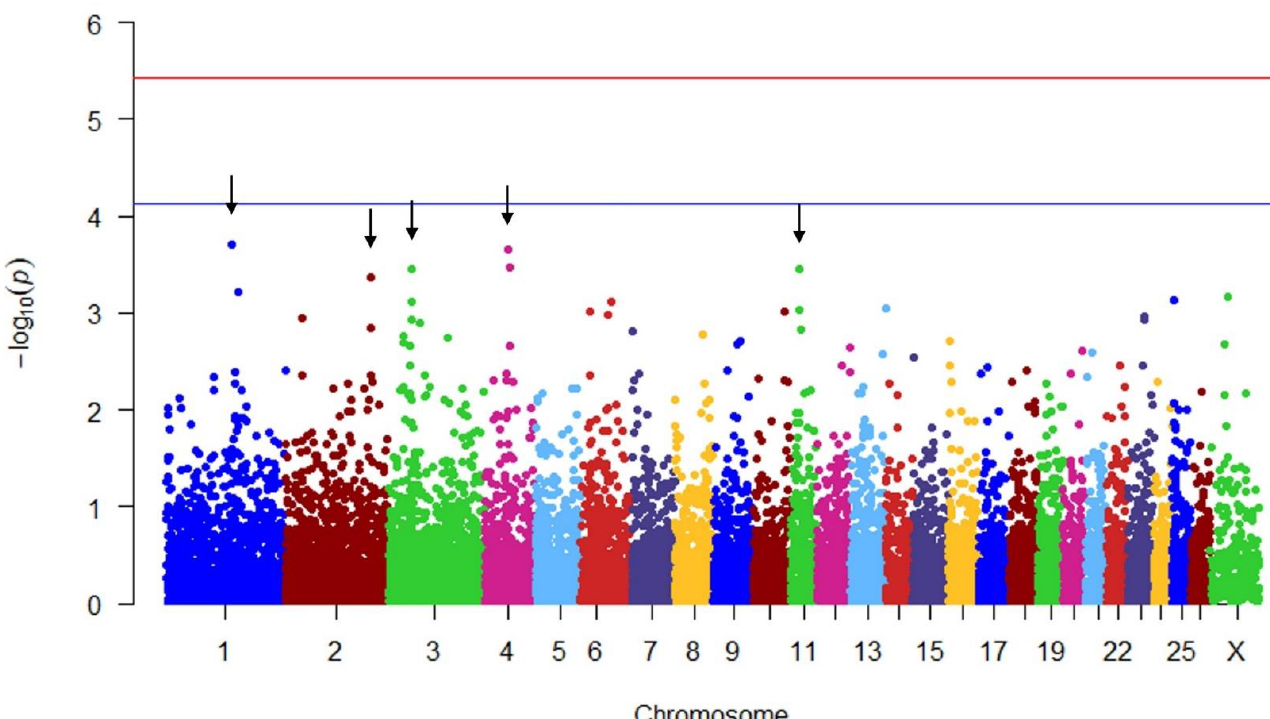
Figure 2. Manhattan plot showing the genome-wide association for the occurrence of pregnancy of ewe lambs when bred first at eight months of age The red line includes the Bonferroni-adjusted genome-wide significant level at −log 10 ( p -value) = 5.43, and the blue line includes the suggestive association significant level at −log 10 ( p -value) = 4.12. The black arrows indicate nearly significant peaks at suggestive significance level. Table 2. Estimates of variance components and heritabilities with their respective standard errors using the pedigree-based additive genetic relationship matrix and genomic relationship matrix for ewe lamb live weight (LWT) or the occurrence of pregnancy (Preg) when bred for the first time, at eight months of age.